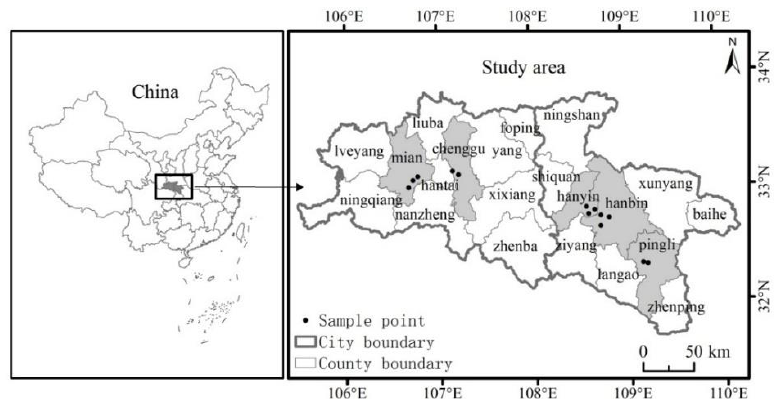
Figure 1. Research area and sampling point distribution.